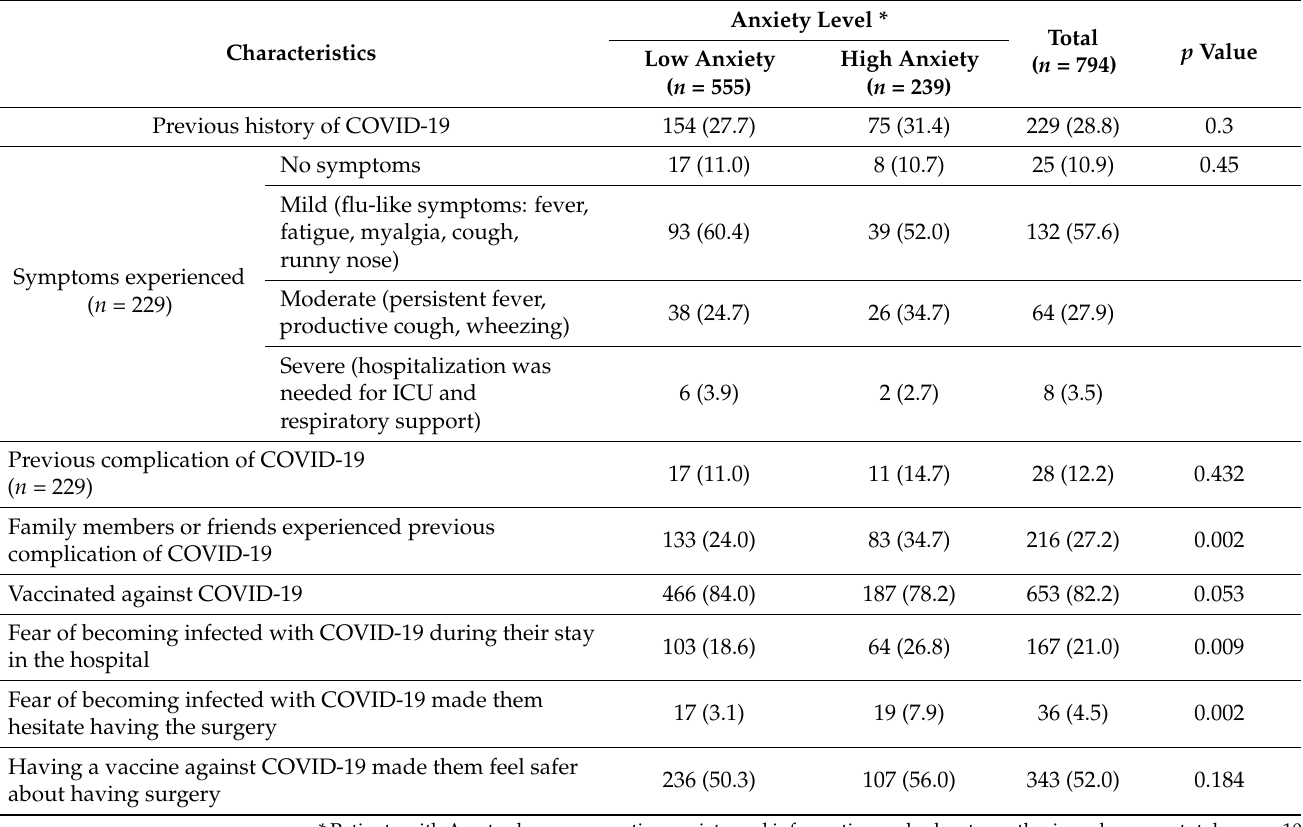
Table 4. History of COVID-19 and COVID-19 vaccination and their relationship with preoperative anxiety.